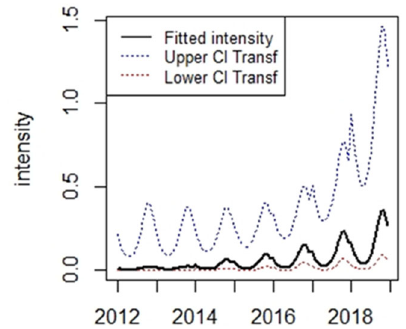
Figure 2. Monthly failure intensity in the study area.